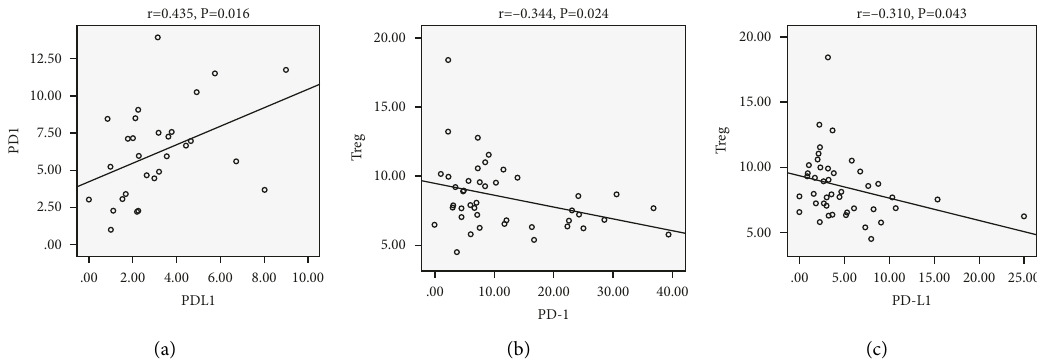
Figure 4: Correlation between PD-1/PD-L1 expression and proportions of peripheral blood CD4 + CD25 + CD127 low Tregs among patients with active pulmonary tuberculosis. (a) Correlation between PD-1 and PD-L1 expression on peripheral blood CD4 + CD25 + CD127 low Tregs among patients with active pulmonary tuberculosis. (b) The association of PD-1 expression with the proportion of peripheral blood CD4 + CD25 + CD127 low Tregs among patients with active pulmonary tuberculosis. (c) The association of PD-L1 expression with the proportion of peripheral blood CD4 + CD25 + CD127 low Tregs among patients with active pulmonary